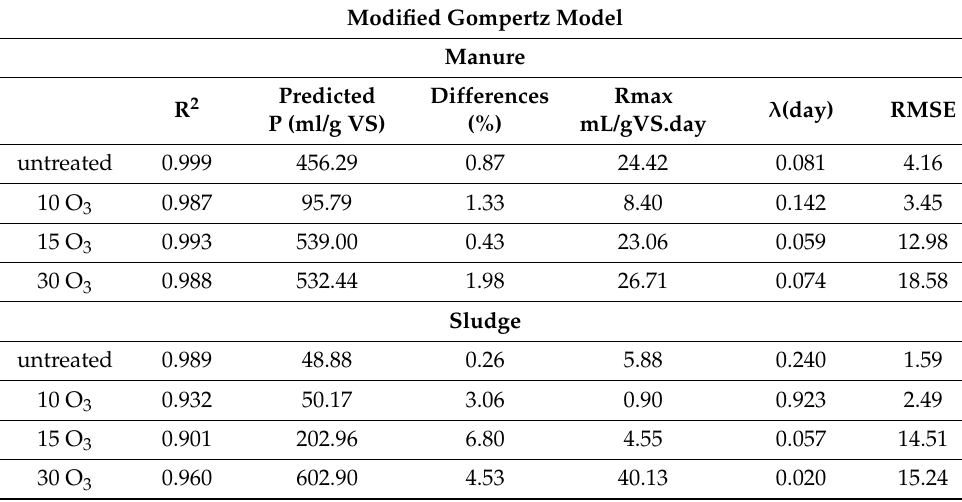
Table 3. Data of kinetic analysis using the modified models of Gompertz and logistic